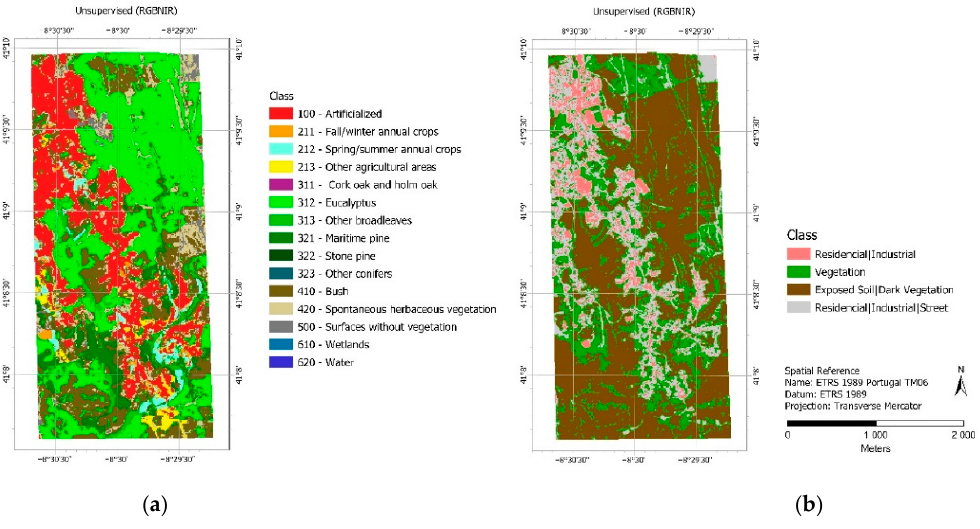
Figure 11. ( a ) COSSim map and ( b ) LULC map.